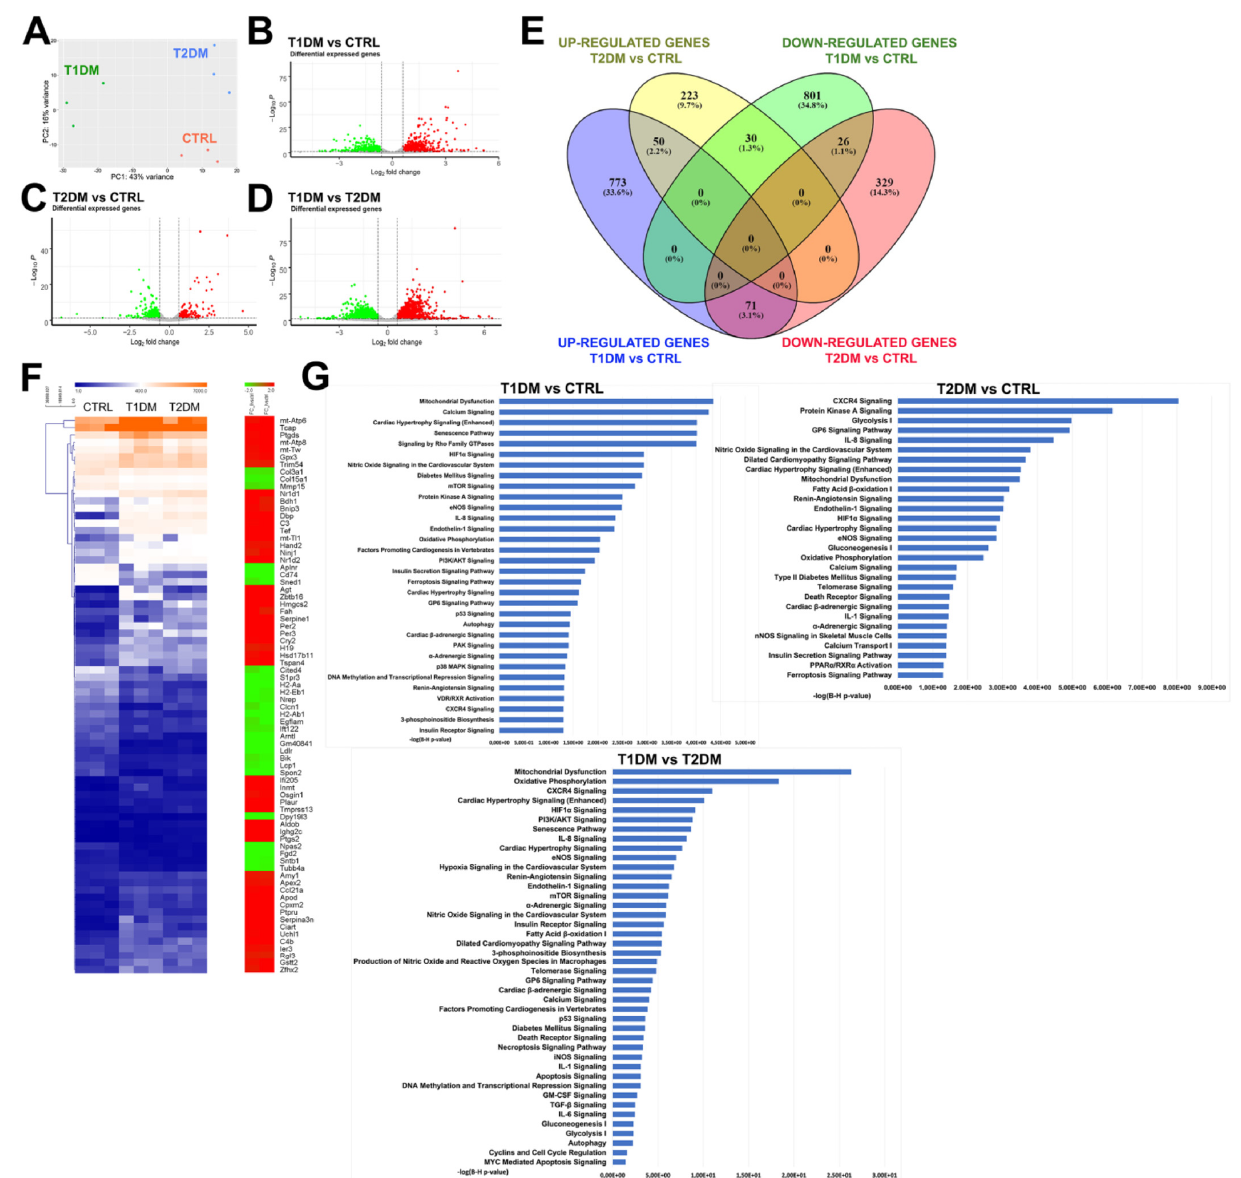
Figure 6. STZ-based T1DM and T2DM mouse models displayed different global transcriptome profiles and gene-expression signatures. ( A ) 2D-PCA analyses based on mRNA expression levels in CTRL, T1DM and T2DM samples (n = 3 per group). ( B – D ) Pairwise analysis of mRNA expressions between T1DM and CTRL, T2DM and CTRL and T1DM and T2DM, plotted in Volcano plots (|FC|1.5 and p ≤ 0.01). Red and green show the most significantly up- and downregulated mRNAs, respectively. ( E ) Venn diagram that shows the distributions of common, downregulated and upregulated genes in T1DM vs. CTRL, T2DM vs. CTRL and T1DM vs. T2DM. ( F ) Heat map showing similar fold changes of the common genes expressed in the two diabetic groups when compared to the same gene expressed in CTRL samples. ( G ) Functional categorization based on ingenuity pathway analysis (IPA) of the most significant canonical pathways generated in T1DM vs. CTRL, T2DM vs. CTRL and T1DM vs. T2DM. The ratio was calculated through division of the number of genes from our data set that mapped to each single pathway by the total number of genes included in the canonical